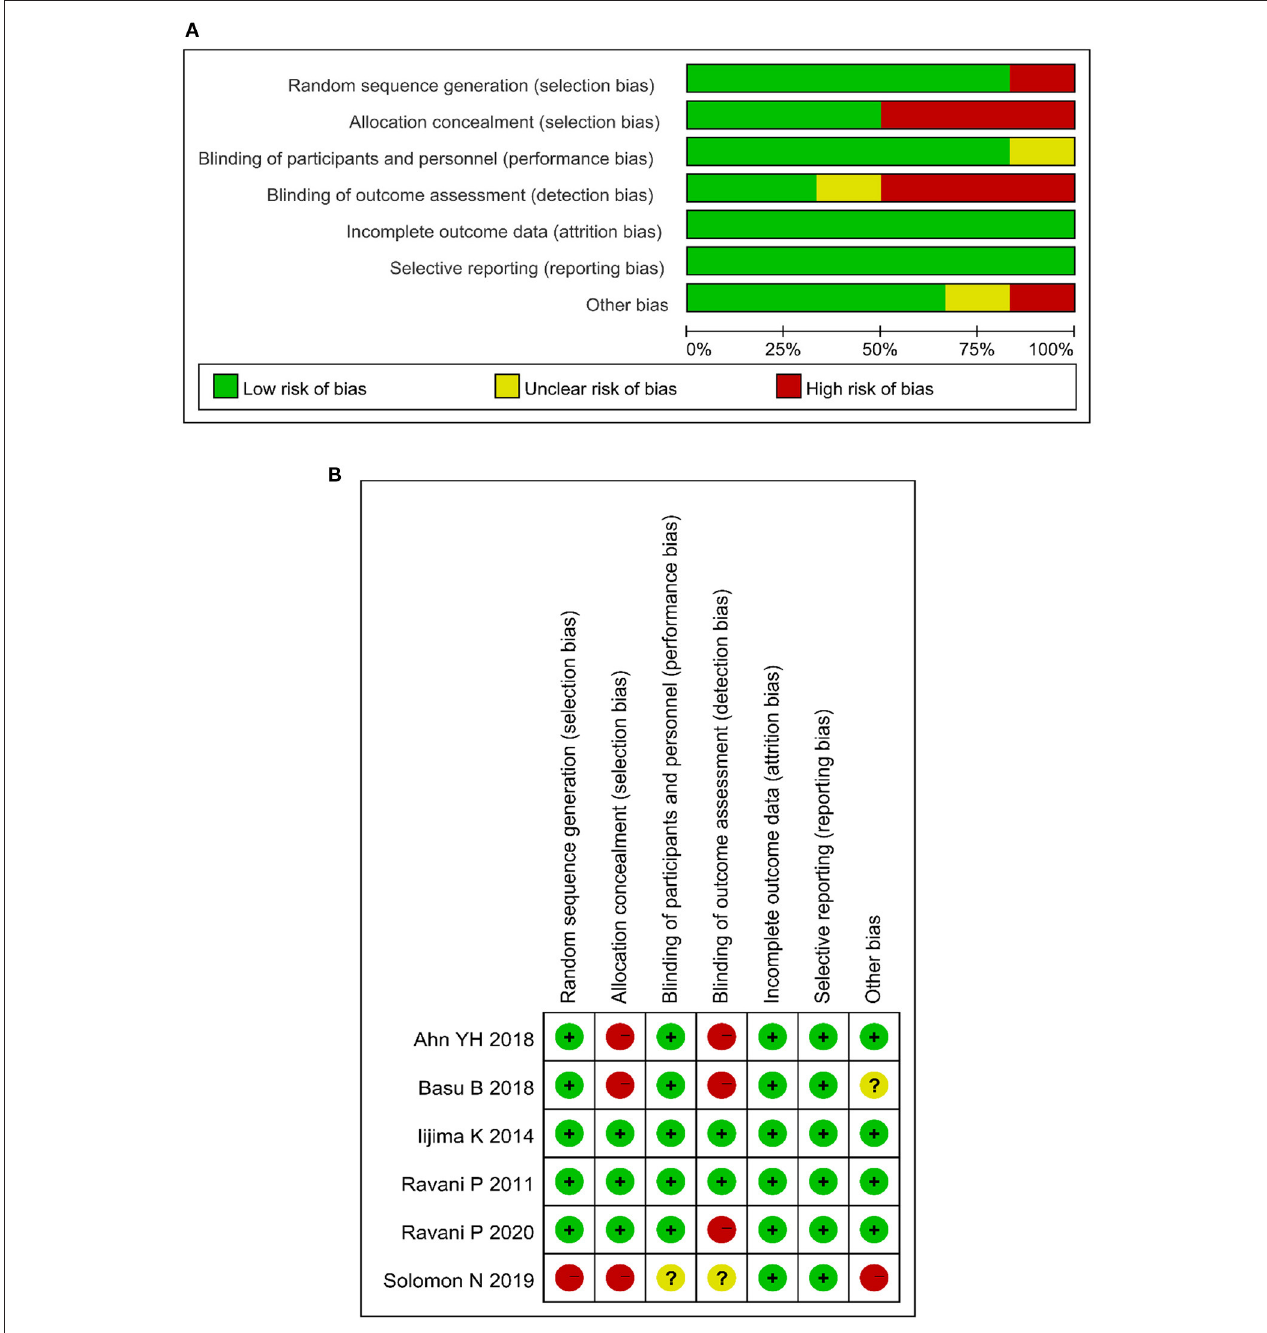
FIGURE 2 | (A) Risk of bias graph. (B) Risk of bias